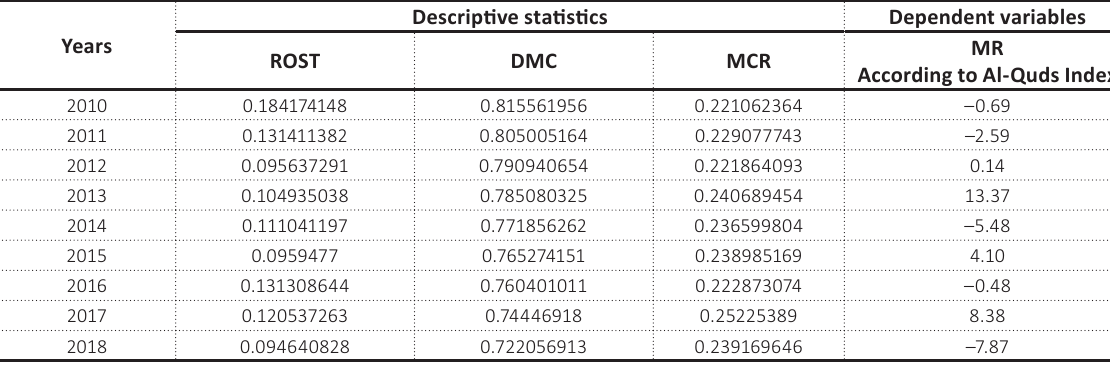
Table A1. Summary of the study